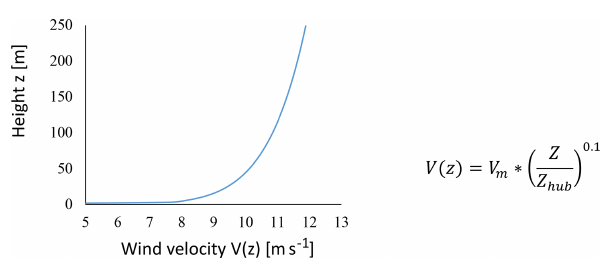
Figure 6. Wind speed profile at the computational domain inlet.